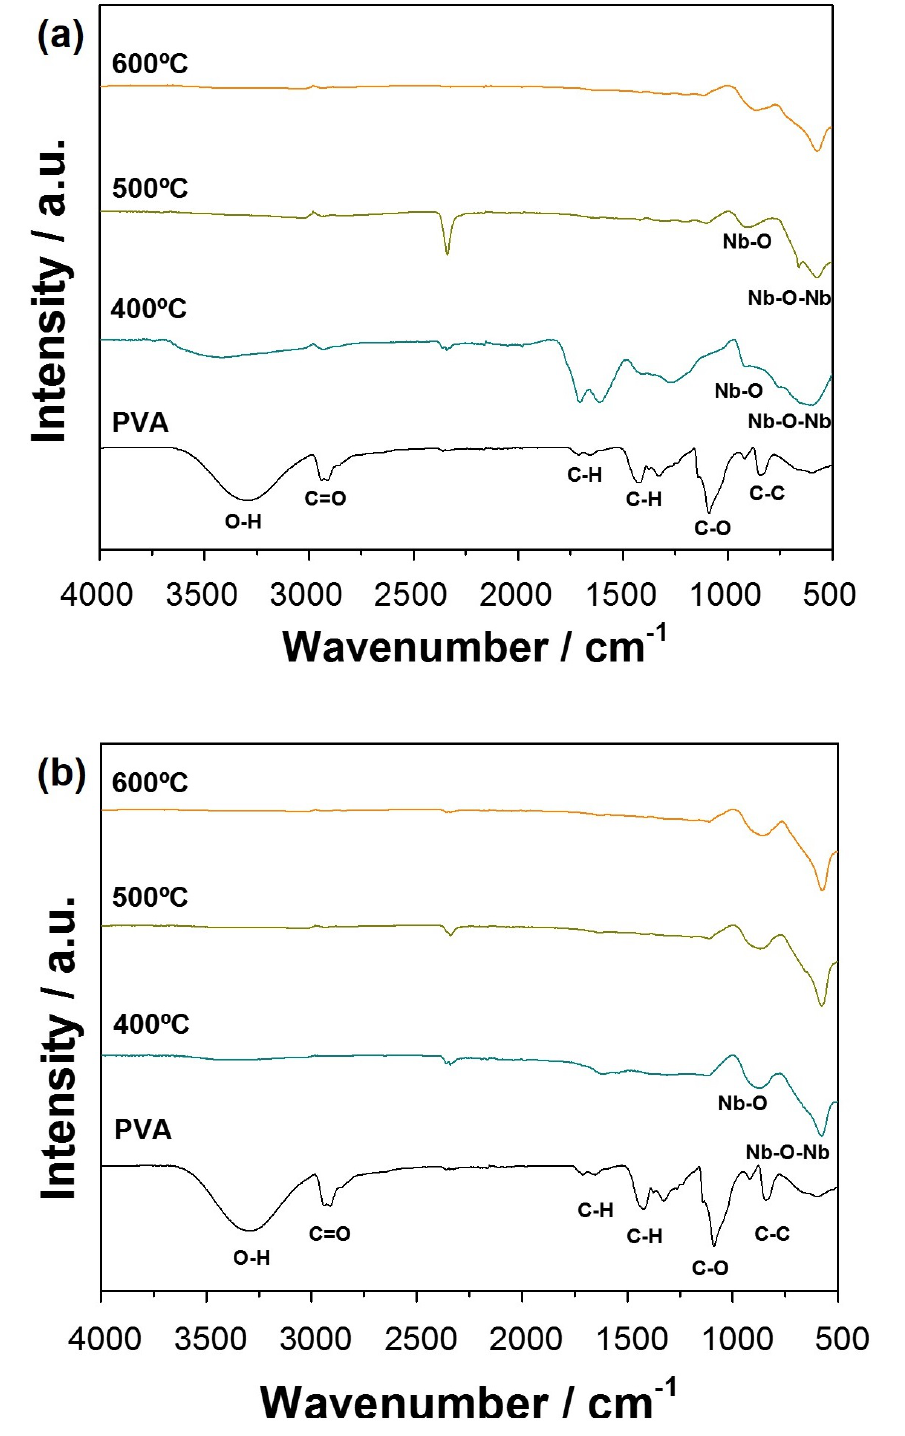
Figure 4. FTIR profiles of PVA and Nb 2 O 5 ceramic fibers after thermal treatments at 400 ◦ C, 500 ◦ C or 600 ◦ C at a heating rate of ( a ) 1 ◦ C min − 1 and ( b ) 10 ◦ C min − 1